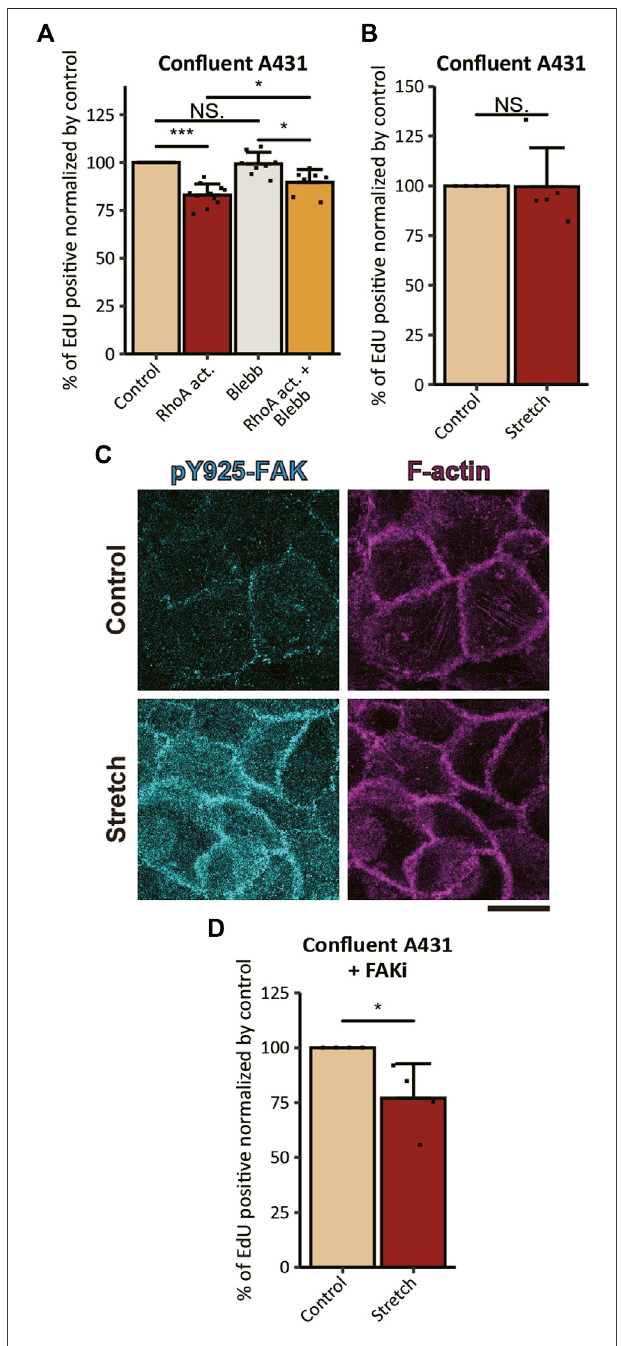
FIGURE 4 | Actomyosin activation and mechanical stretch inhibit the proliferation of cSCC cells. (A) Ratios of EdU-positive nuclei in con fl uent A431 cells treated with 5 μ g/ml RhoA activator (RhoA act.), 100 μ M p -aminoblebbistatin (Blebb) or combination of both drugs (RhoA act. + Blebb) for 6 h followed by incubation with EdU for 2 h in the presence of the same compounds. Values were normalized with the mean value in control cells. Each bar represents mean ± SD. n ≥ 8 independent experiments. * p < 0.05; *** p < 0.001; NS, p > 0.05. (B) Ratios ofEdU-positive nuclei in con fl uent A431 cells without FAKi treatment under static (Control) and 20% UPS (Stretch) conditions. Values were normalized with the mean value in the static